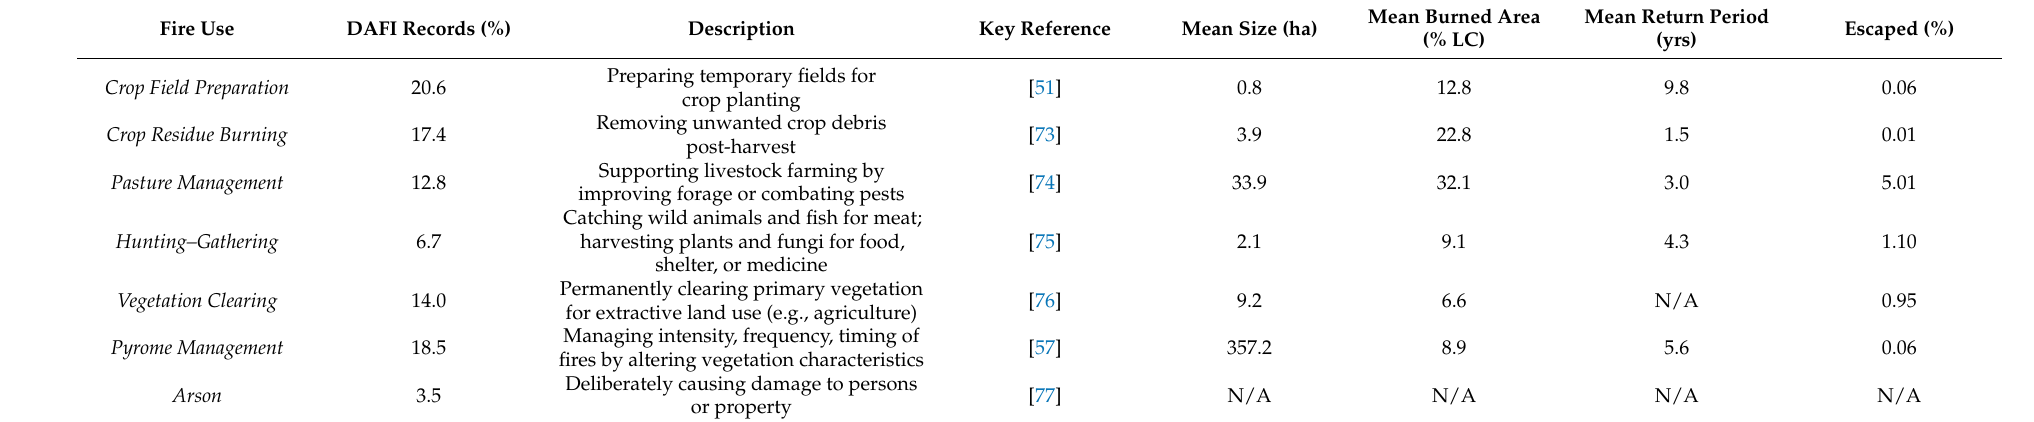
Table 2. Seven main modes of fire use identified from meta-study. Proportions of DAFI records are calculated based on unique fire use instances (as case studies can contain multiple fire uses). Mean burned area is as a percentage of the target land cover. Full details on identifying the main modes are presented in Appendix A (Table